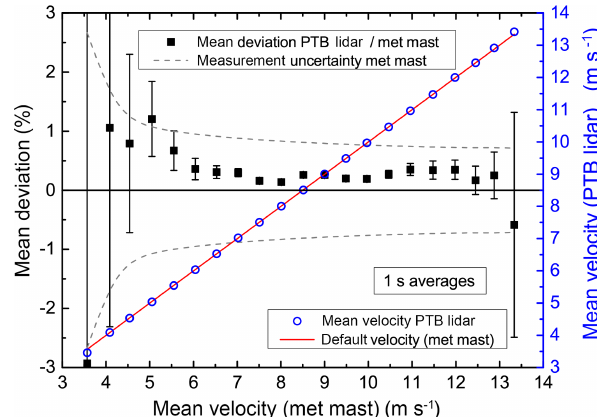
Figure 6. Comparison of PTB lidar with wind met mast for undis- turbed wind conditions (campaign